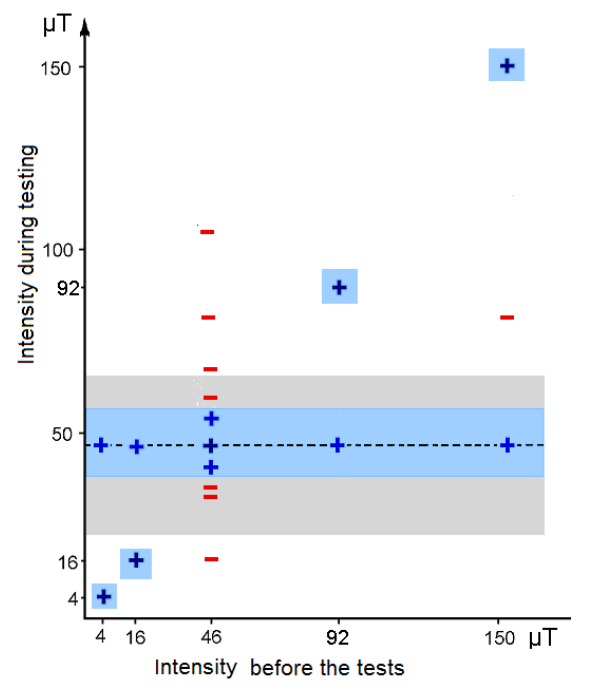
Figure 2. The functional window of the magnetic compass and its flexibility: orientation of robins in various magnetic intensities. Blue: +, oriented behavior; red: −, disoriented behavior. The dashed line marks the local intensity of the capture site, 46 μT. The blue zones indicate the estimated functional range of the magnetic compass in birds kept in the intensity indicated at the abscissa; the grey zone marks the intensity range presently found on Earth (data from